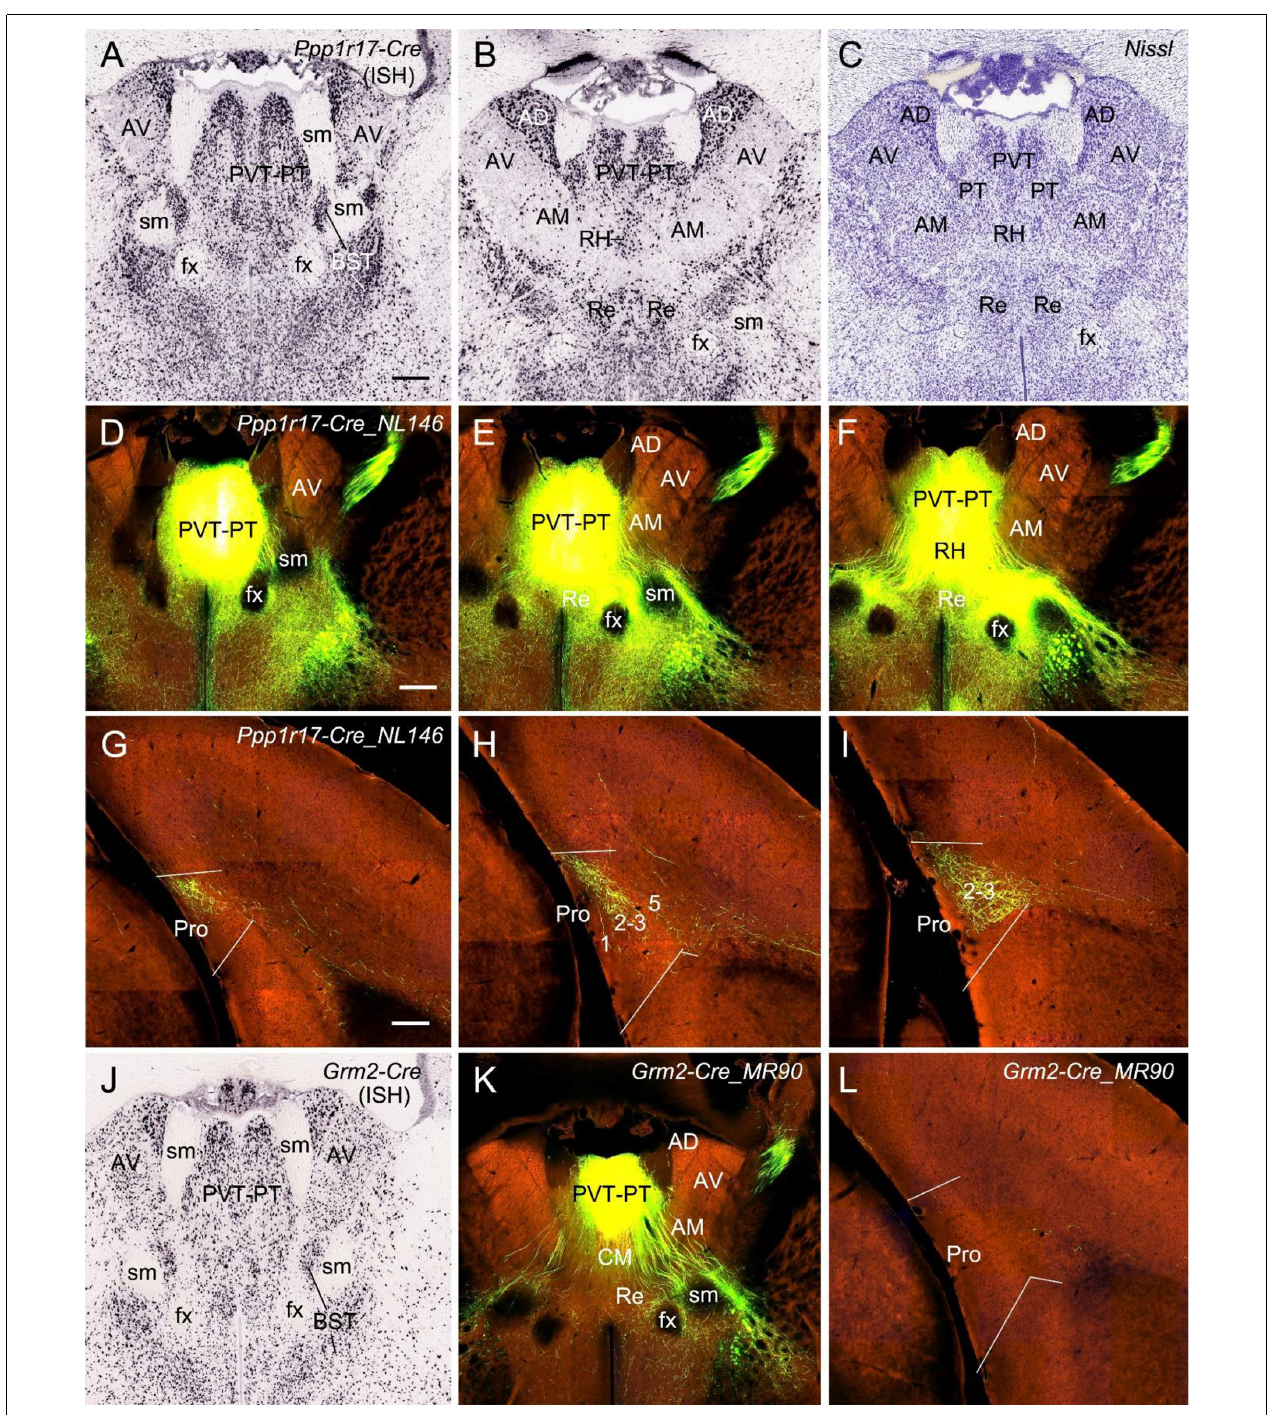
FIGURE 11 | Projections from anterior midline thalamic region to the Pro. (A–B) Two sequential sections of the anterior midline thalamic region (ATh) showing Ppp1r17 -Cre expression in paraventricular-parataenial nuclei (PVT-PT) and adjoining RH, AD, and AM. (C) A Nissl-stained section adjacent to (B) showing the architecture of the PVT-PT and adjoining regions. (D–I) One large injection in the PVT-PT and the adjoining ATh structures (D–F) of a Ppp1r17 -Cre_NL146 mouse leads to strong terminal labeling in L2–3 of the Pro with much fewer in deep L1 (G–I) . Panels (D–F) are three serial sections of the ATh, and (G–I) are three sequential sections of the prostriata region. (J) One section at the level (A) showing Grm2 -Cre expression in the PVT-PT and adjoining regions. (K,L) One smaller injection in the PVT-PT (K) of a Grm2 -Cre_MR90 mouse produces no terminal labeling in the Pro (L) . Bar: 330 µ m in (A) (for A–C and J ); 350 µ m in (D) (for D–F, K ); and 200 µ m in (G) (for G–I and L